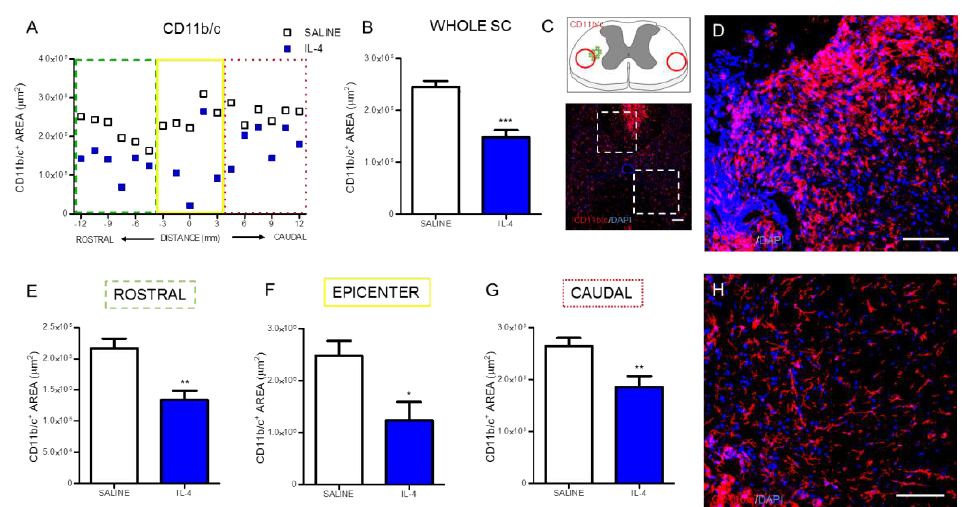
Figure 2. IL-4 treatment reduces the area of macrophages/microglia in the injured spinal cord. Distribution of the CD11b/c + area along the rostrocaudal axis of the spinal cord ( A ). Quantification of CD11b/c + area in the whole spinal cord revealed a significant reduction of macrophages in IL-4-treated rats ( B ); A significant reduction of CD11b/c + area was also observed in the rostral ( E ); epicenter ( F ) and caudal ( G ) regions of the injured spinal cord. Schematic and low-magnification photomicrograph indicating areas where the analyses were performed (dashed lines) ( C ); Representative images of positive staining for macrophages/microglia of saline ( D ) and IL-4 treated ( H ) group. Values shown as mean ± SEM. * p < 0.05; ** p < 0.01; *** p < 0.001. Scale bar = 100 μm.